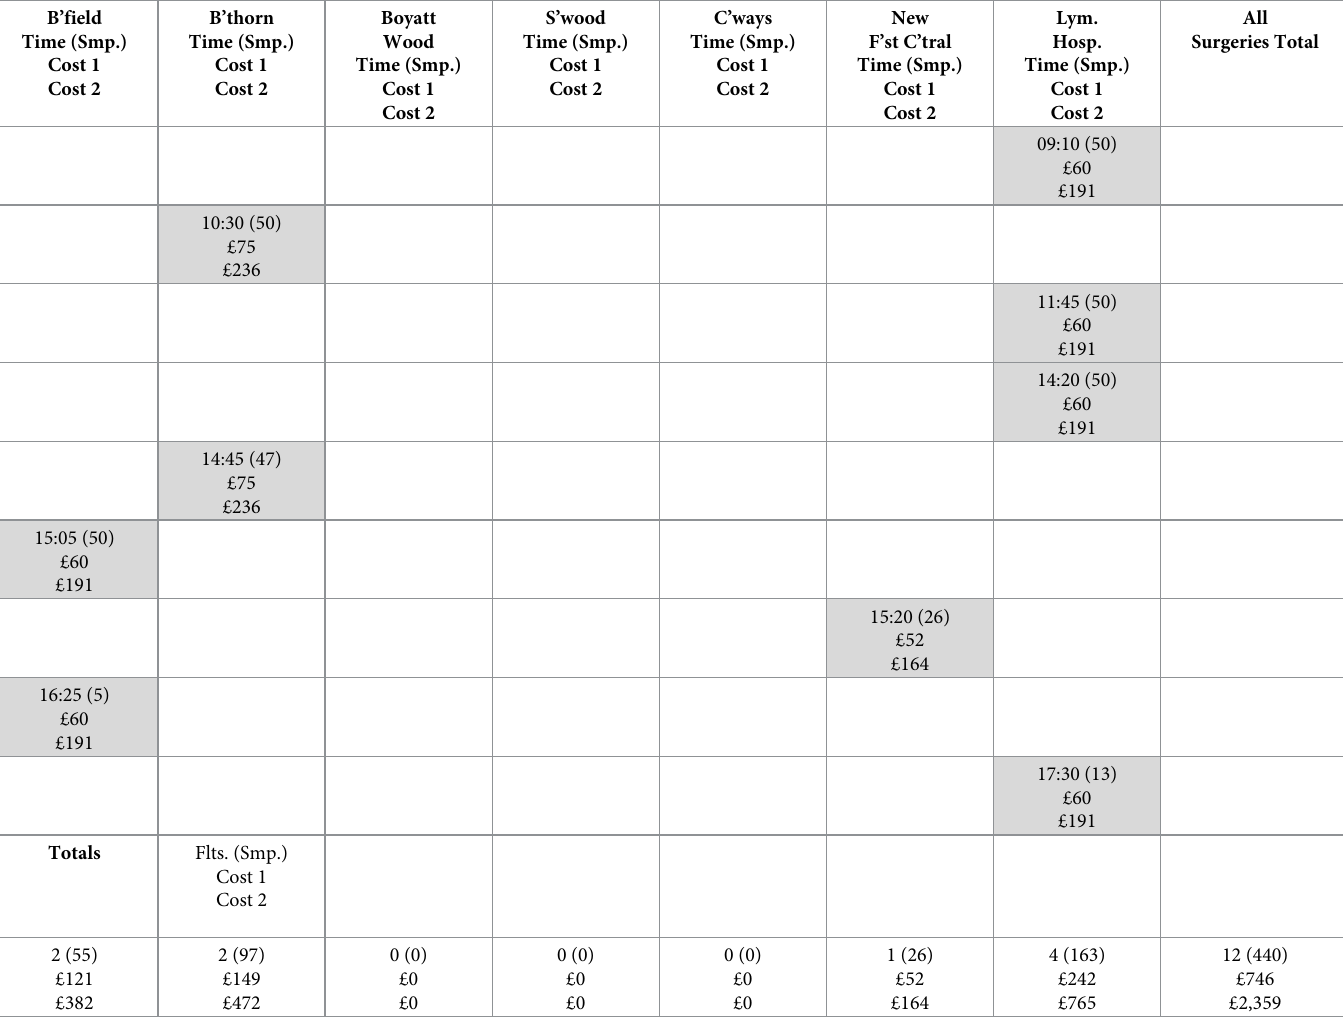
Table 2. Example daily flight schedule for the UAV collection service. B’field Time